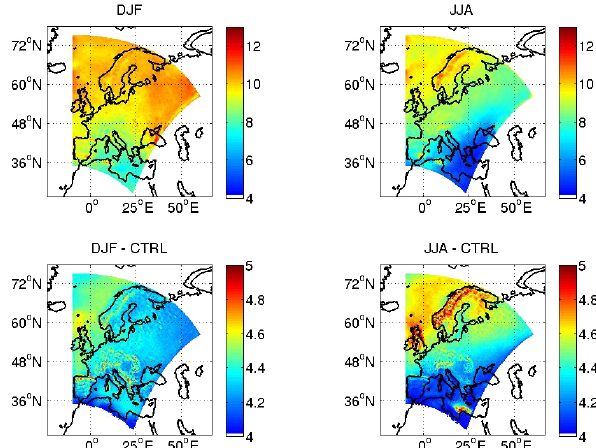
Figure 7. Seasonal mean CD radii (µm) averaged over the entire water cloud for DJF mean and JJA mean in the MOD simulations (top row) and CTRL simulation (second row). Note the difference in